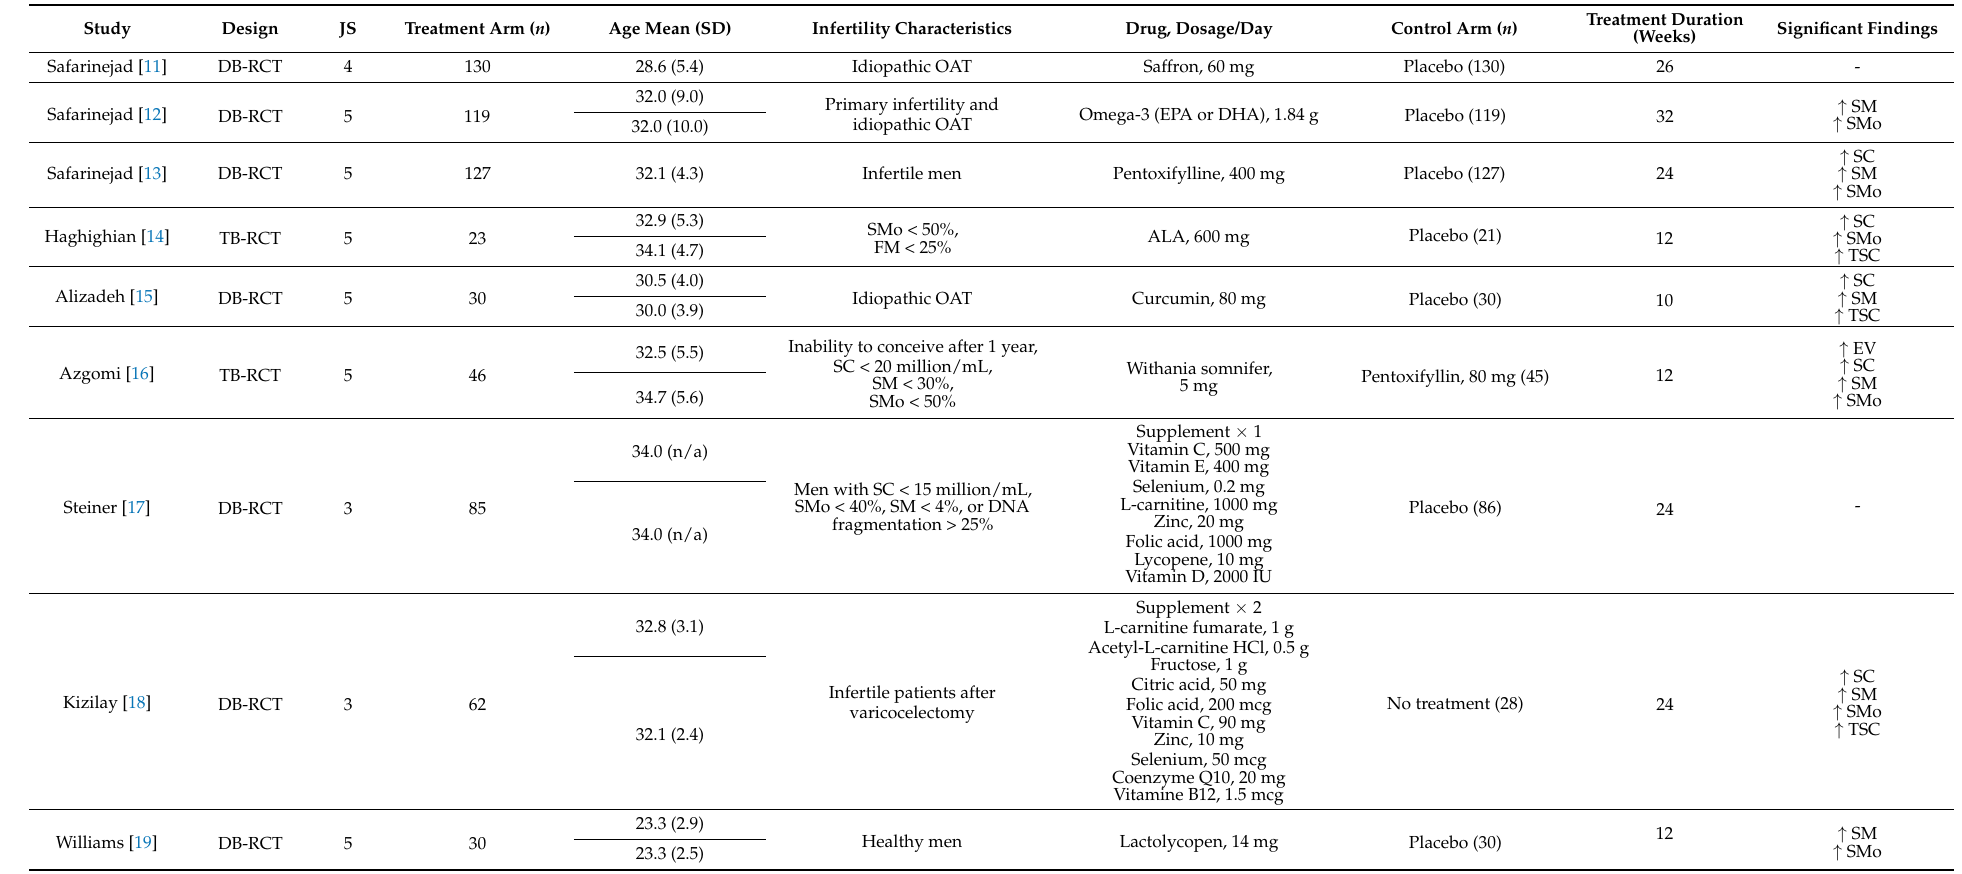
Table 1. Study characteristics, patients’ demographics, and treatment